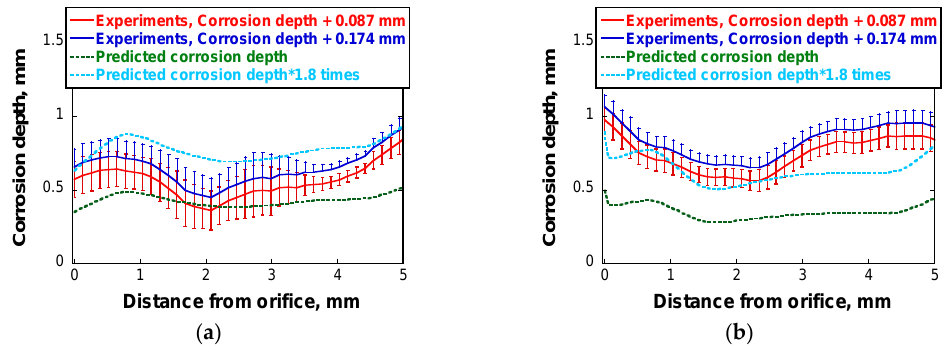
Figure 19. Comparison of the predicted corrosion depths calculated from Equation (9) using the mass concentration difference and the corrosion depths measured from the OM images at the two orifices. Note that the fabrication deviations of 0.087 mm and 0.174 mm are added in the experimental corrosion depth, respectively, and the predicted corrosion depths of the inlet orifice and outlet orifice were multiplied by a scaler of 1.8 to take the wall roughness into consideration. ( a ) Inlet orifice; ( b ) Outlet orifice.